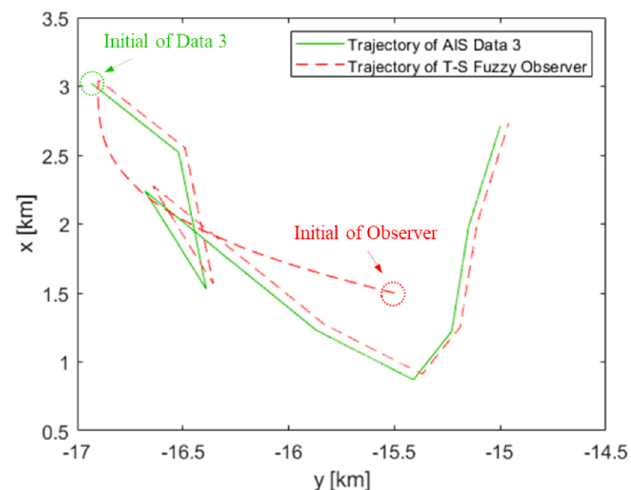
Figure 17. Observed results of AIS data 3.